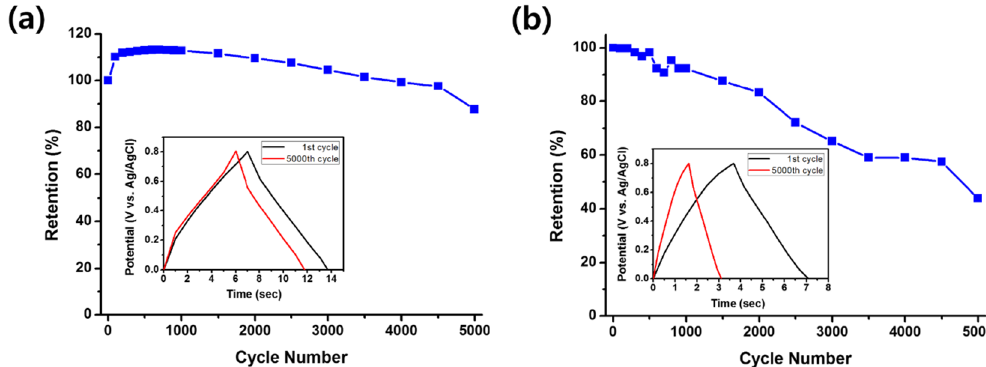
Figure 5. Cyclic stability of MnO 2 electrodes. Plots of C sp retentions for ( a ) 5Lyr nanostructured and ( b ) planar MnO 2 electrodes as a function of the number of galvanostatic charge-discharge cycles. The number of MnO 2 electrodeposition cycles was 60 for both electrodes. (Inset) Galvanostatic charge-discharge curves measured after 1 and 5000 cycles at a constant current density of 1.0 mA cm − 2